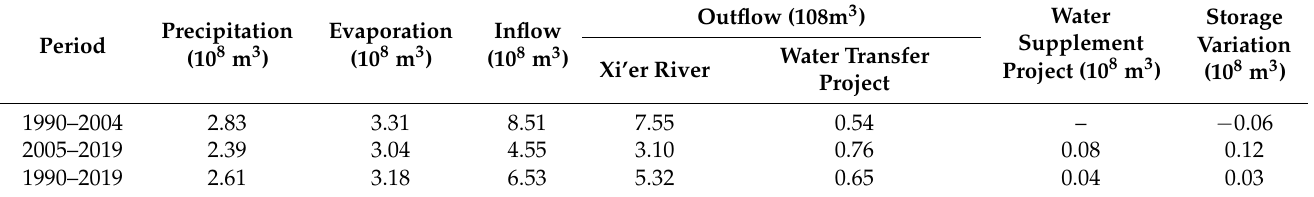
Table 2. Elements of water balance in Erhai